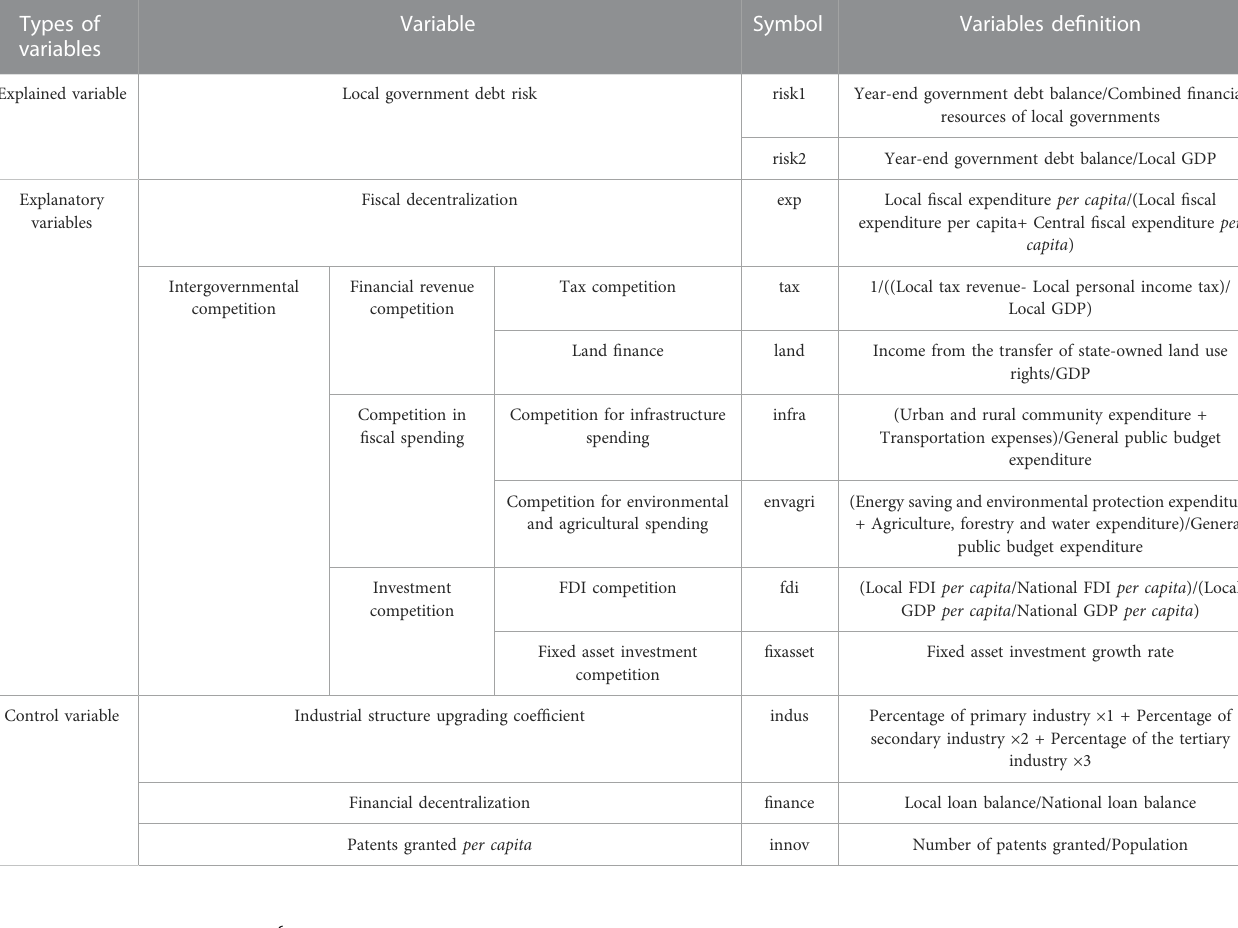
TABLE 1 Variable names and de fi nitions. Types of